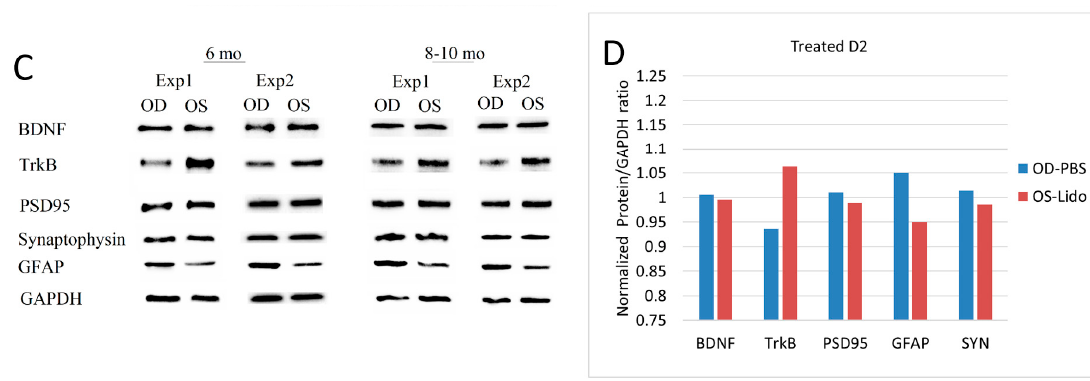
Figure 4. Age-related changes of relevant protein expression in untreated (A,B) and Lidocaine-treated (C,D) DBA/2J mice. ( A ) Western Blot images of Brain Derived Neurotrophic Factor (BDNF) (28 kDa), Tyrosine Receptor Kinase B (TrkB) (140 kDa), PSD95 (95 kDa), Synaptophysin (SYN) (38 kDa), Glial Fibrillary Acidic Protein (GFAP) (50 kDa) and Glyceraldehyde 3-phosphate Dehydrogenase GAPDH (37 kDa) proteins assessed in untreated mice of different ages (3 mice for age group, pooled retinas of both eyes); ( B ) Average protein expression (normalized protein/GAPDH ratio) as as function of age in untreated mice. Bars represent the average of 6 retinas for age group; ( C ) Representative Western Blot images of relevant retinal proteins in mice 6 and 8–10 old that received 4 retrobulbar injections of Lidocaine in the left eye and PBS in the right eye at 4 months of age; ( D ) Average protein expression in Lidocaine-treated (OS) and PBS-treated (OD) eyes. Bars represent the average ratios of 9 D2 mice of 6–10 months of age.